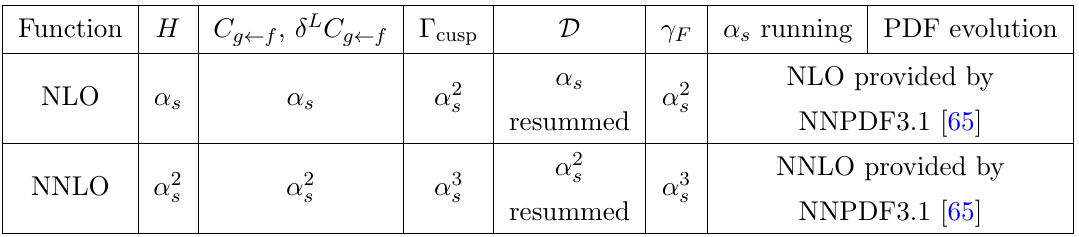
Table 1 . Summary of perturbative orders used for each part of the cross section. The symbol H stands for the (cid:12)rst line of eq.